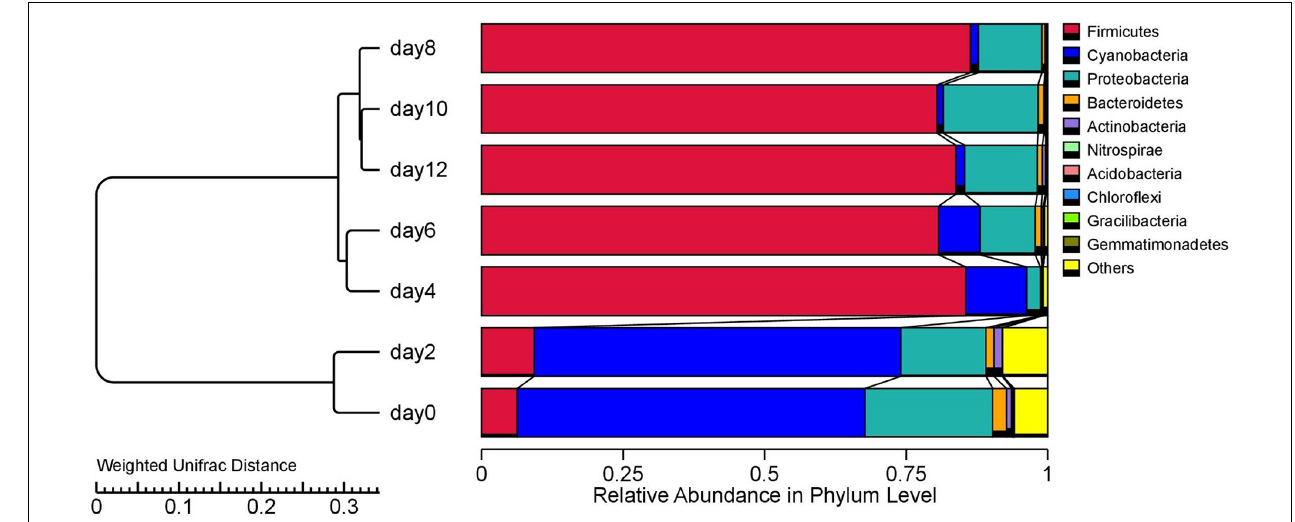
FIGURE 2 | The relative abundance of bacterial phyla (top 10) at different stages of